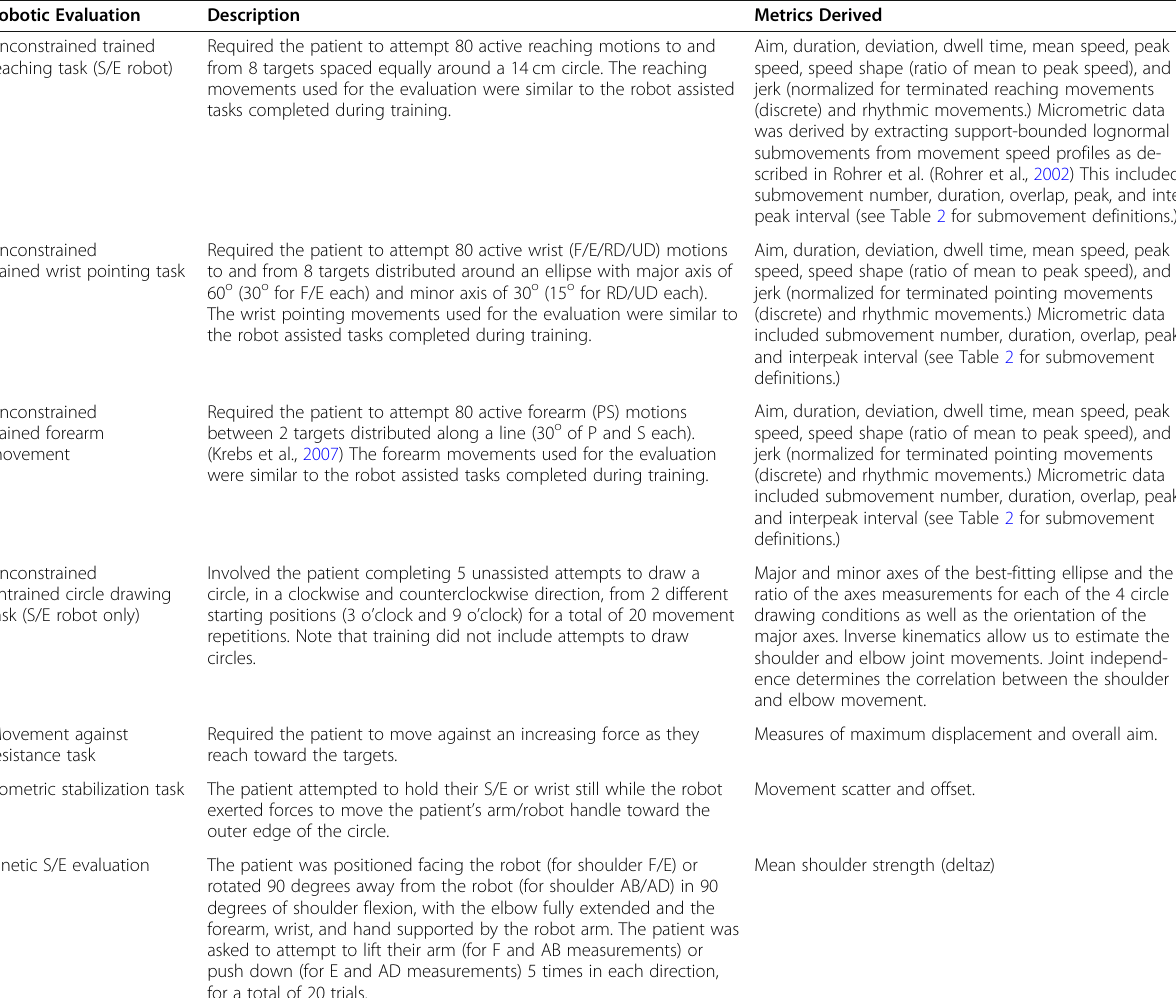
Table 1 Outline of robotic evaluation tasks and the metrics derived from the evaluations Robotic